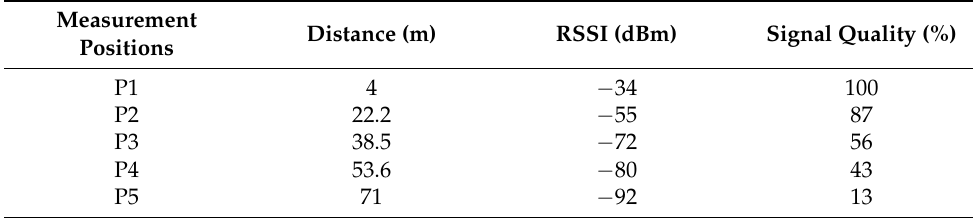
Figure 10. Plan of the Electronic department of ETSE (Univ. Valencia): the gateway is placed inside our laboratory. P1 to P5 are the different positions of the BLE sensor node. Table 3. The distances between the measurement positions and the gateway, the average RSSI [dBm], and the signal